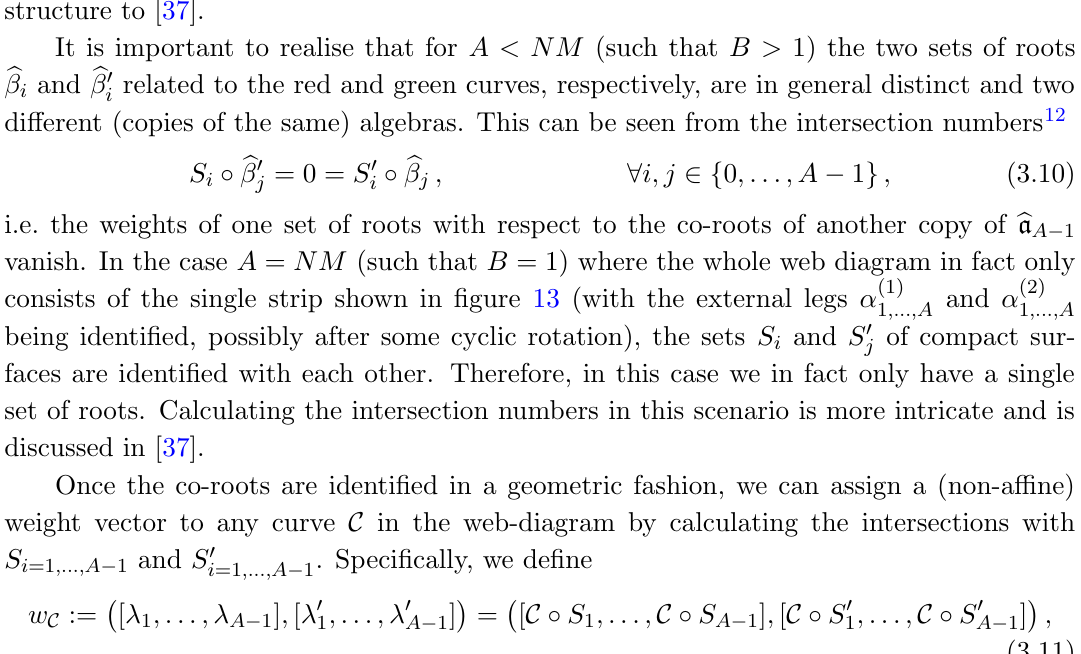
Figure 13 . Strip with two sets of compact surfaces labeled by S i and S 0 correspond to roots with respect to S i ( S 0 indicate how the strip is glued into the web diagram of the Calabi-Yau